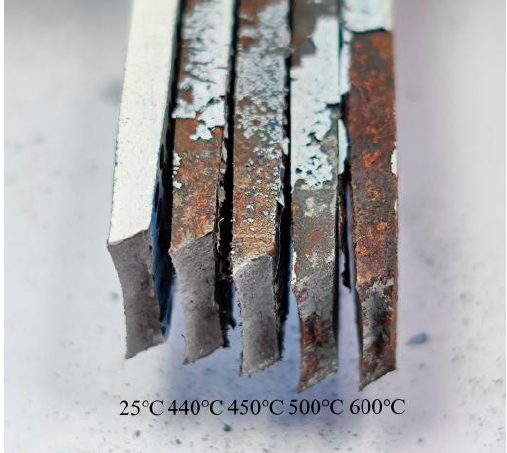
Figure 13. Fracture diagram of tensile specimen.